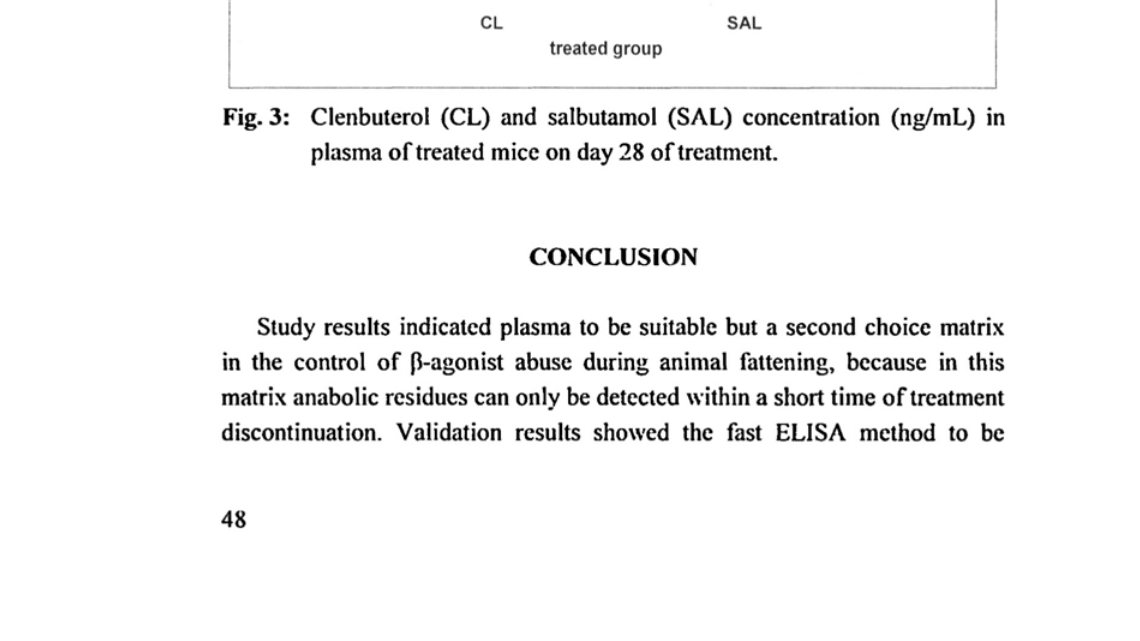
Fig. 3: Clenbuterol (CL) and salbutamol (SAL) concentration (ng/mL) in plasma of treated mice on day 28 of